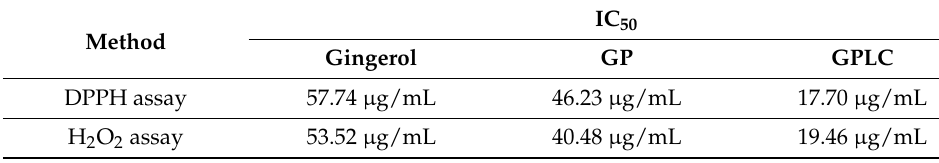
Table 4. In vitro antioxidant study (adapted from Refs. [54,56]).